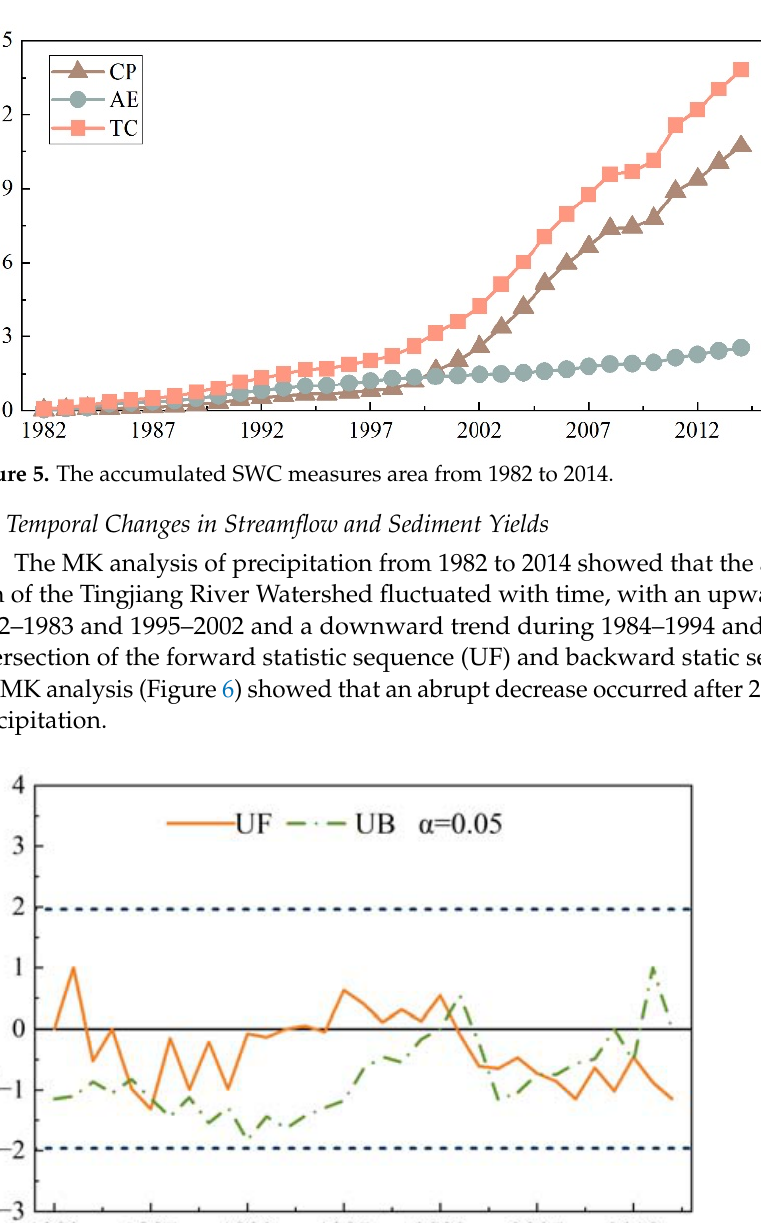
Figure 6. The MK trend test of annual precipitation. In BW and TW, the MK curves of the annual streamflow exhibited similar fluctuation patterns. The annual streamflow showed an upward trend in the 1990s and a downward trend since the beginning of the 21st century. The intersection of the UF and UB indicated that the abrupt and significant change ( p < 0.05) in annual streamflow occurred in BW and TW in 2003 and 2000, respectively (Figure 7a,c). This showed the annual streamflow in the two watersheds in recent years was significantly lower than that before 2000. In BW, the annual sediment yields demonstrated a fluctuating pattern, while in TW, it showed first a rising then a declining pattern. However, a similar pattern that increased in the 1990s and then declined since the beginning of the 21st century was observed for in both BW and TW. The UF and UB curves of the annual sediment yields intersected in 2008 and 2001 (Table 1), respectively, which indicated the abrupt change time for the annual sediment yields (Figure